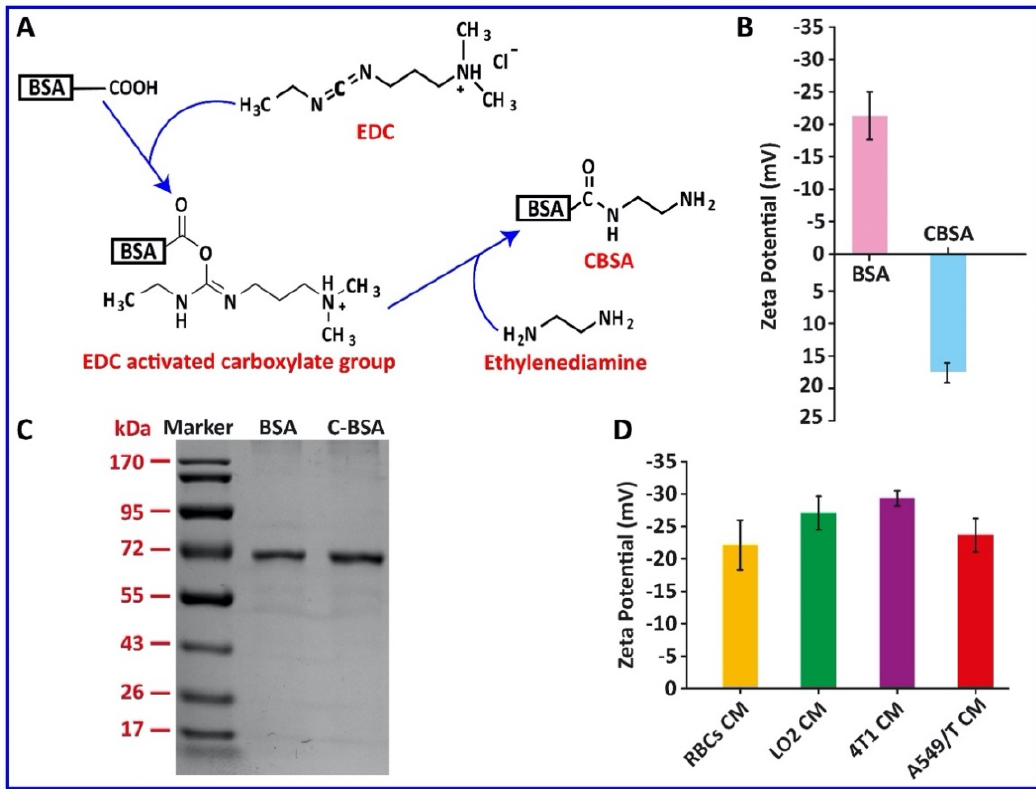
Figure 1. Synthesis and characterization of CBSA and different cell membrane vesicles. ( A ) Synthesis scheme of CBSA by ethylenediamine modification, ( B ) surface charge of native and CBSA, ( C ) SDS-PAGE of native BSA and CBSA, ( D ) surface charge of different cell membrane vesicles.